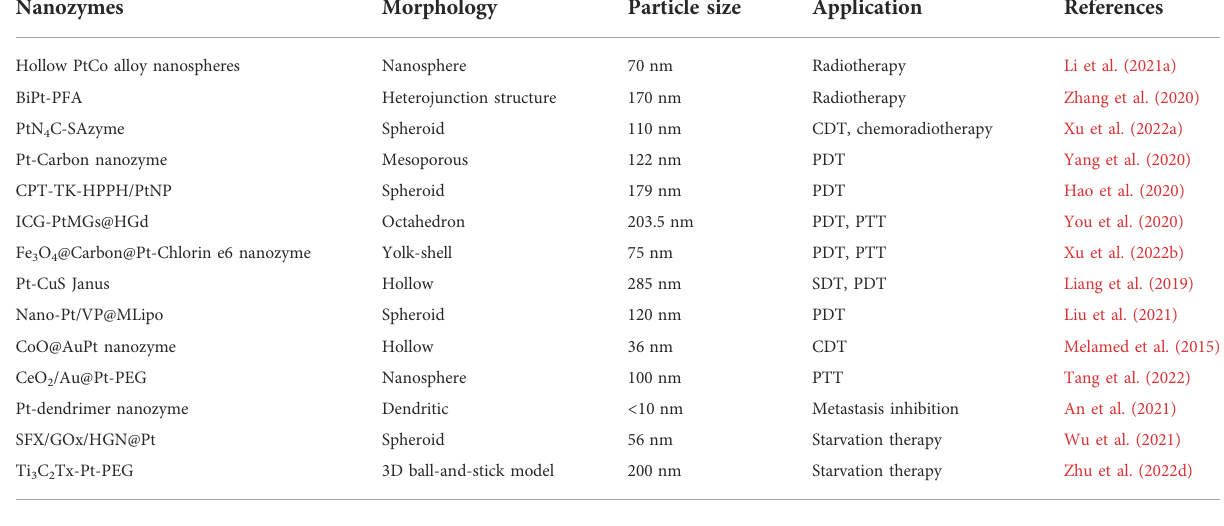
TABLE 1 Pt nanozymes classi fi cation and application.